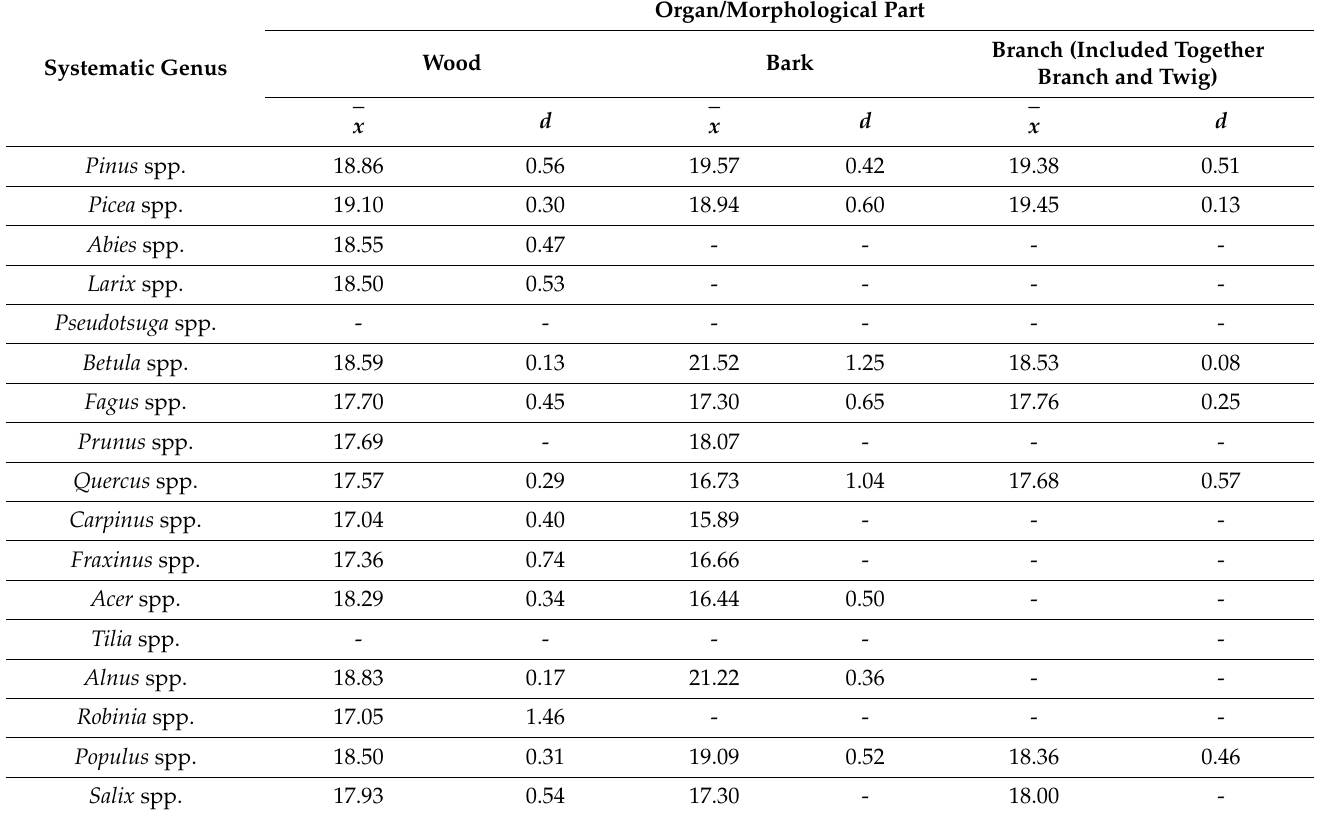
Table A11. Average value and average deviation of the LHV (MJ kg − 1 d.m.) of various organs of particular systematic genera